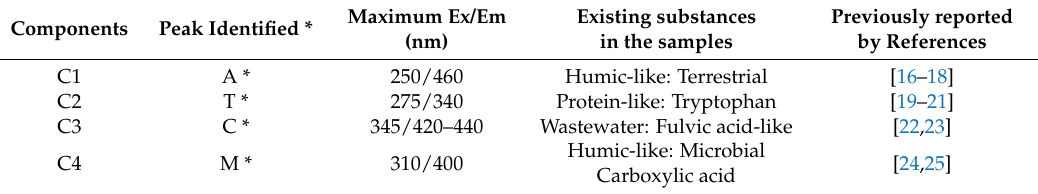
Table 1. Peaks identified from parallel factor analysis (PARAFAC)-derived components and compared with other